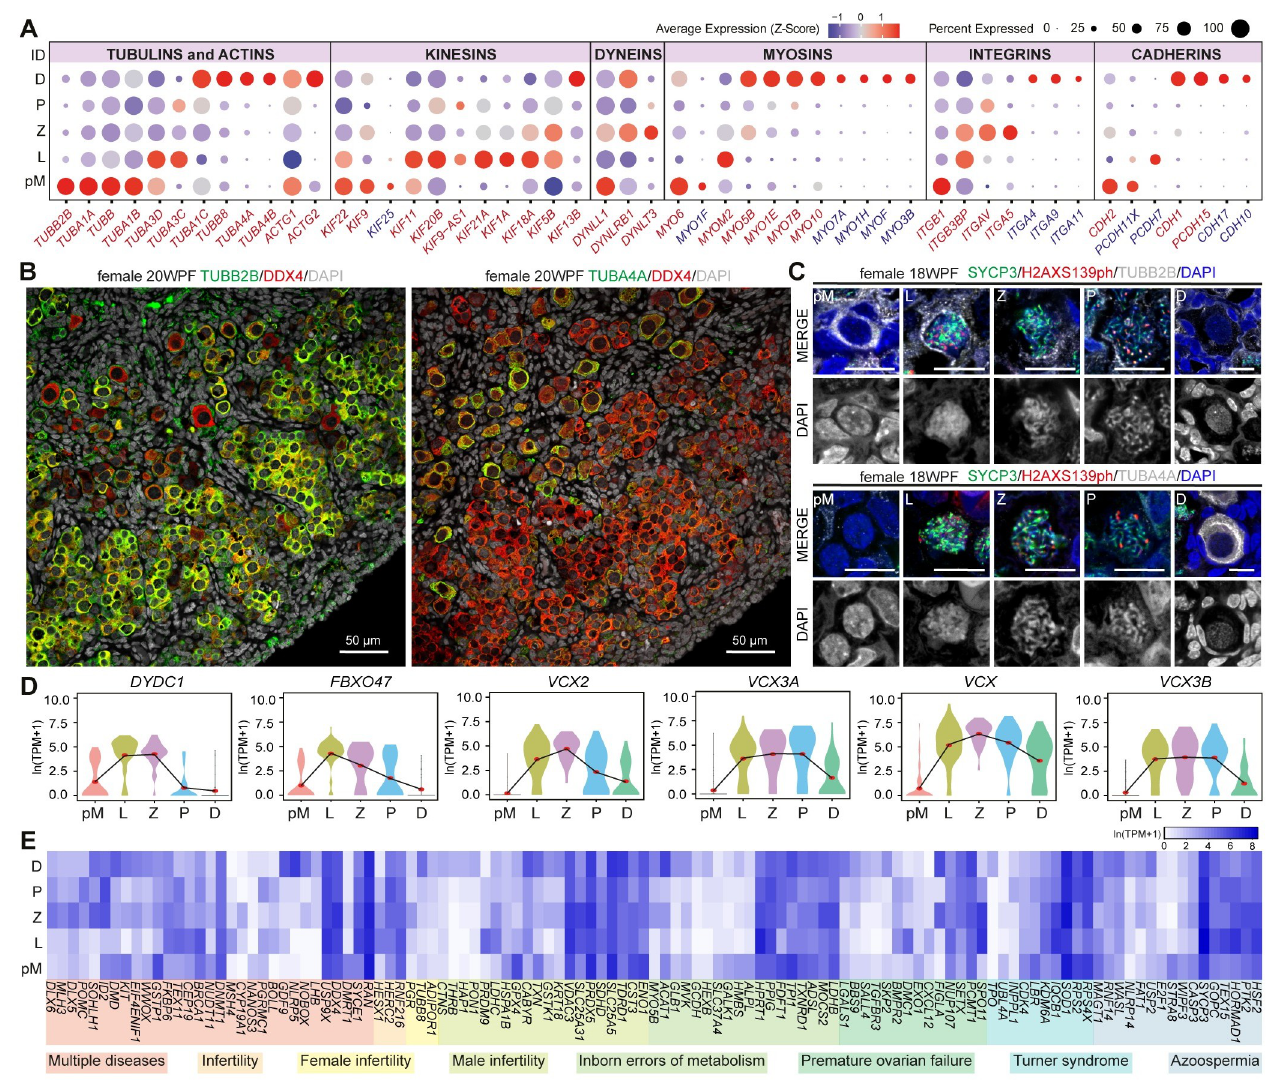
Fig 2. Expression of cytoskeletal and adhesion genes in female meiotic prophase I. (A) Dot plot showing scaled average expression (Z-score) of the cytoskeleton, motor and cell adhesion gene families in different meiotic prophase I stages (pre-meiotic, pM; leptotene, L; zygotene, Z; pachytene, P and dictyate/diplotene, D). Gene names in red are fDEGs and in blue are not fDEGs. (B) Immunofluorescence of 20WPF ovary for TUBB2B (left) and TUBA4A (right) with DDX4. Scale bars are 50 μ m. (C) Immunofluorescence of 18WPF ovary for TUBB2B (top) and TUBA4A (bottom) with SYCP3 and H2AXS139ph in selected FGC in pM, L, Z, P and D. Scale bars are 10 μ m. (D) Violin plots showing expression dynamics of selected fDEGs. Red dots mark mean expression per cluster. (E) Heatmap showing expression of fDEGs associated with reproductive-related